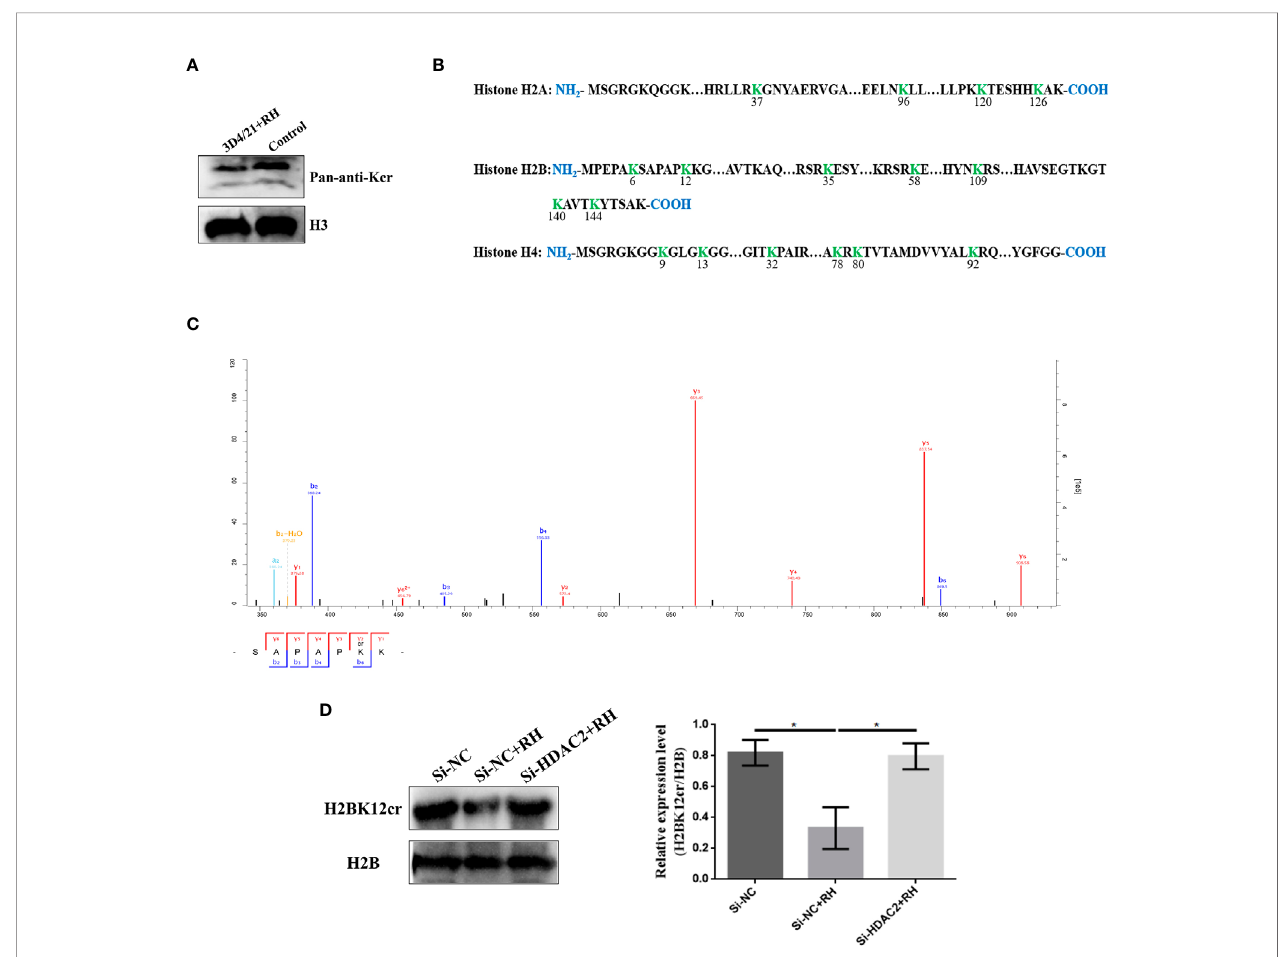
FIGURE 3 | T. gondii infection negatively regulates histone crotonylation in porcine alveolar macrophages. (A) Detection by immunoblotting of Kcr in histone isolated from control and 3D4/21+RH cells. (B) Histone Kcr sites detected by quantitative proteomics analysis. (C) Full MS and MS/MS spectra for K12cr of H2B. (D) Western blot analysis of the expression levels of H2BK12cr. The data are presented as the mean ± SEM of three independent experiments. *p < 0.05, one-way